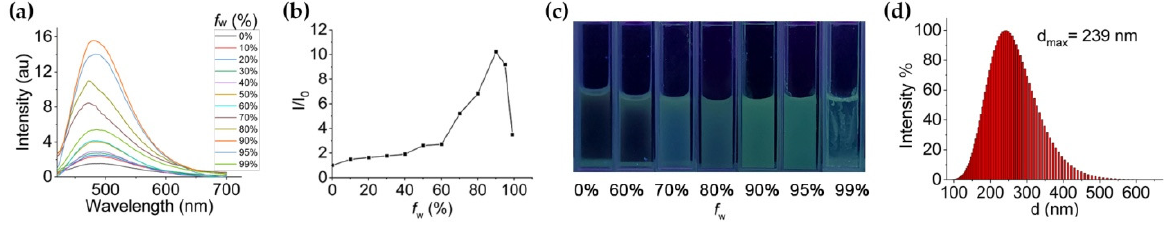
Figure 2. AIE properties of BTE-2PBT triad. ( a ) PL spectra of BTE-2PBT in THF and water/THF mixtures with different water fractions ( λ ex = 365 nm); ( b ) Plot of I / I 0 value vs. water fraction; ( c ) Photographs of BTE-2PBT in different water fractions taken under 365 nm UV; ( d ) Dynamic light scattering (DLS) of BTE-2PBT in 90% water/THF mixture.